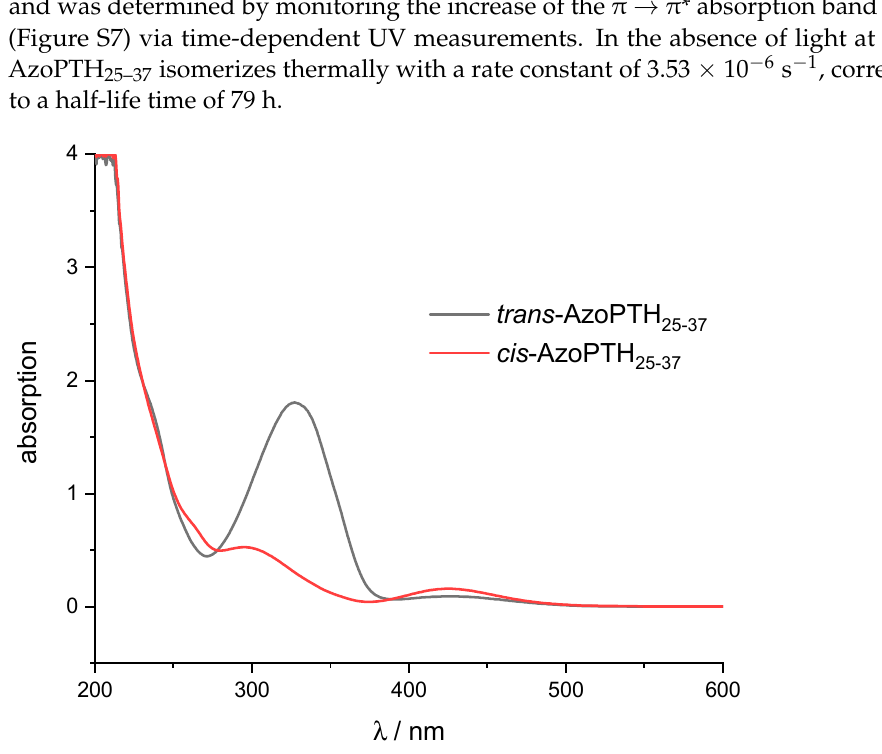
Figure 3. UV/Vis absorption spectra for trans -AzoPTH 25–37 after synthesis and for the cis -enriched photo-stationary state after irradiation at 340 nm, which almost corresponds to cis -AzoPTH 25–37 .